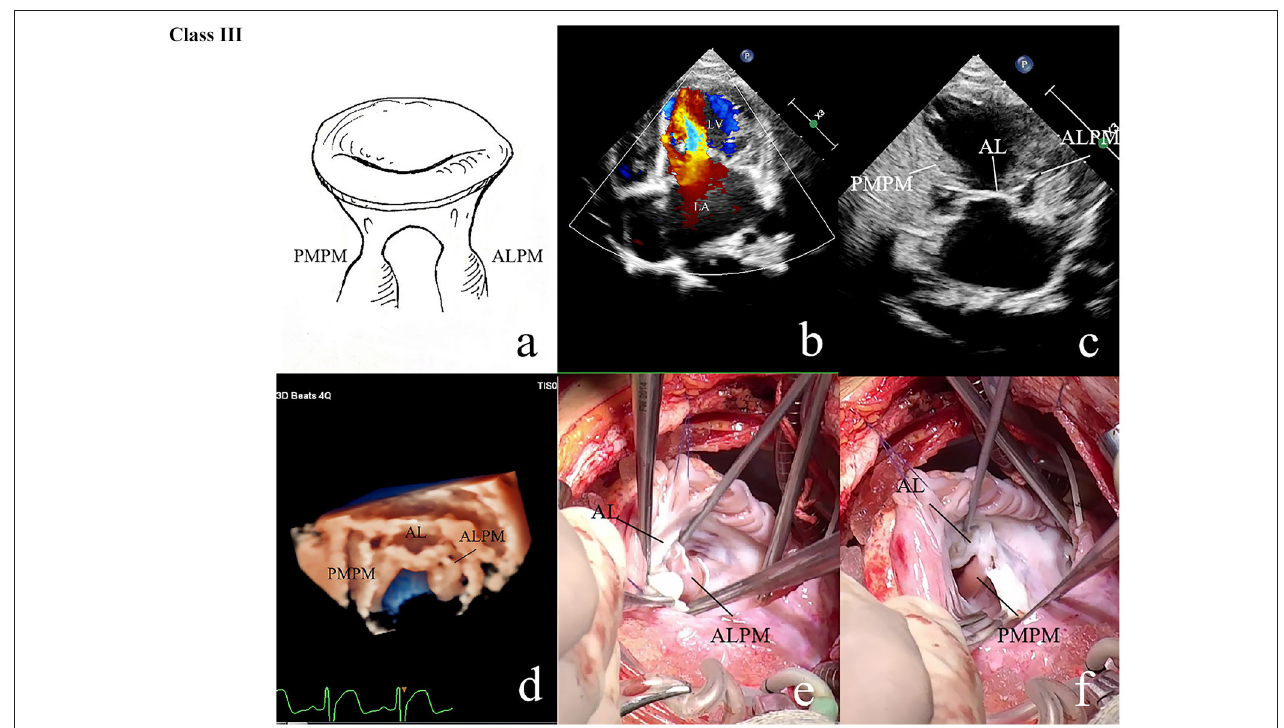
FIGURE 1 | 2D and 3D echo and surgical exploration of the three UCMV classes. Class I : (a) Anatomic diagram of class I of UCMV. Restricted MV insufficiency. The ALCT are undifferentiated, and the ALPM is hypertrophic and elongated and is directly connected with the AL. The PMPM and PMCT are relatively normal. (b) The colour Doppler of 2D echo shows restricted severe mitral regurgitation (Carpentier classification: type IIIA). (c) 2D echo shows that the ALCT are absent and the ALPM is hypertrophic and elongated and is directly connected with the AL. The PMPM and PMCT are relatively normal. (d) 3D echo shows the absent ALCT and the hypertrophic and elongated ALPM being directly attached to the AL, and the PMCT and PMPM being normal. (e) Surgical exploration shows that the ALPM is directly connected with the anterior commissure of the AL, and ALCT are absent. (f) Surgical exploration shows that the PMCT are relatively normal. Class II : (a) Anatomic diagram of class II. Restricted MV insufficiency. Both the ALCT and PMCT are undifferentiated. ALPM and PMPM are hypertrophic and elongated and are directly connected with the AL. (b) The colour Doppler of 2D echo shows restricted mitral regurgitation. (c) 2D echo shows that both the ALCT and PMCT are almost absent, and the ALPM and PMPM, which are hypertrophic and elongated and directly connected with the AL. (d) 3D echo shows the hypertrophic and elongated ALPM and PMPM, which are directly connected with the AL. The ALCT and PMCT are absent. (e) Surgical exploration shows that the ALCT are absent, and the extremely hypertrophic ALPM are directly attached to the AL. (f) Surgical exploration shows that the PMCT are absent, and the extremely hypertrophic PMPM are directly connected with the AL. Class III : (a) Anatomic diagram of class III. Restricted MV stenosis. Both the ALCT and PMCT are absent. The ALPM and PMPM are hypertrophic and elongated and are directly connected with the AL. (b) The colour Doppler of 2D echo shows high speed blood flow over the MV orifice due to MV stenosis (Carpentier classification: predominant valve lesion with normal papillary muscle for MS). (c) 2D echo shows that both the ALCT and PMCT are absent. The ALPM and PMPM are hypertrophic and elongated and are directly connected with the AL. (d) 3D zoom echo shows hypertrophic and elongated ALPM and PMPM, which are directly connected with the AL. The ALCT and PMCT are absent. (e) Surgical exploration shows the hypertrophic ALPM union with the AL. (f) Surgical exploration shows the hypertrophic PMPM union with the AL. MV, mitral valve; 2D, two dimensional; 3D, three dimensional; AL, anterior leaflet; ALCT, chordae tendineae attached to the anterolateral papillary muscle; ALPM, anterolateral papillary muscle; PMCT, chordae tendineae attached to the posteromedial papillary muscle; PMPM, posteromedial papillary muscle; UCMV, undifferentiated chordae tendineae of mitral